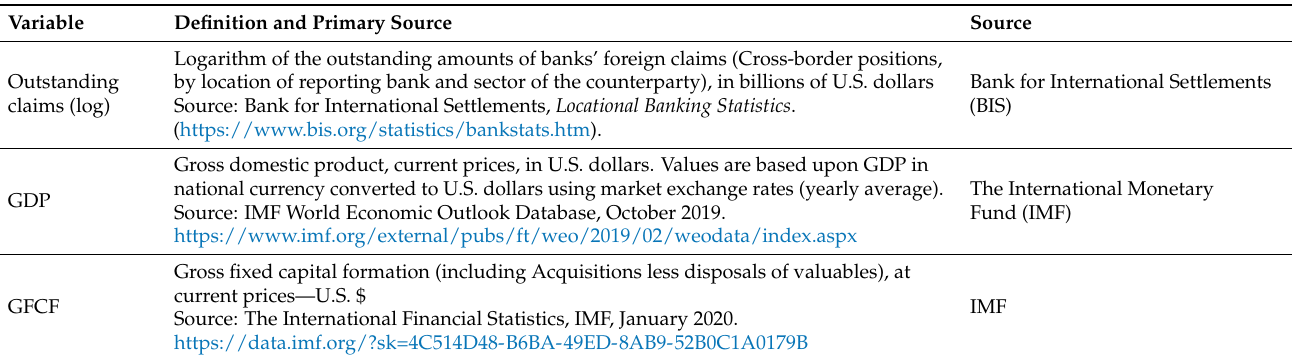
Table A1. Definition of